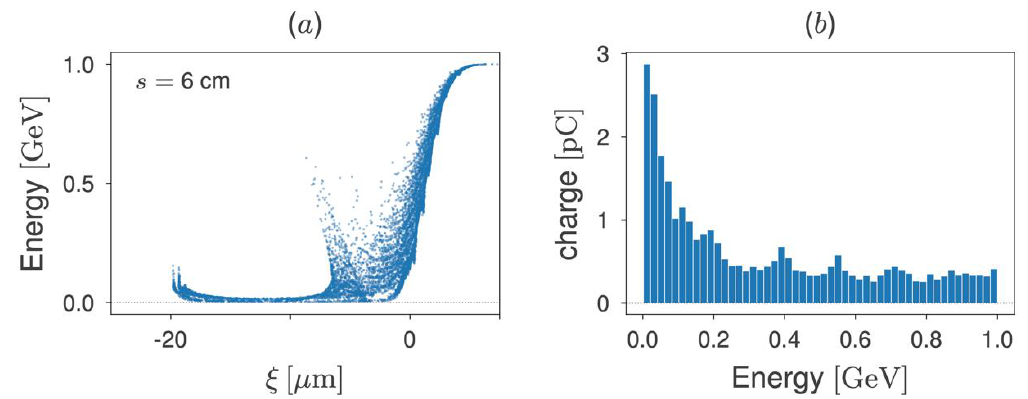
Figure1. ( a )TheEuPRAXIA1GeVbeamlongitudinalphasespaceand( b )energyspectrum, bothplotted Figure 1. ( a ) The EuPRAXIA 1 GeV beam longitudinal phase space and ( b ) energy spectrum, both after 6 cm propagation in plotted after 6 cm propagation in plasma.